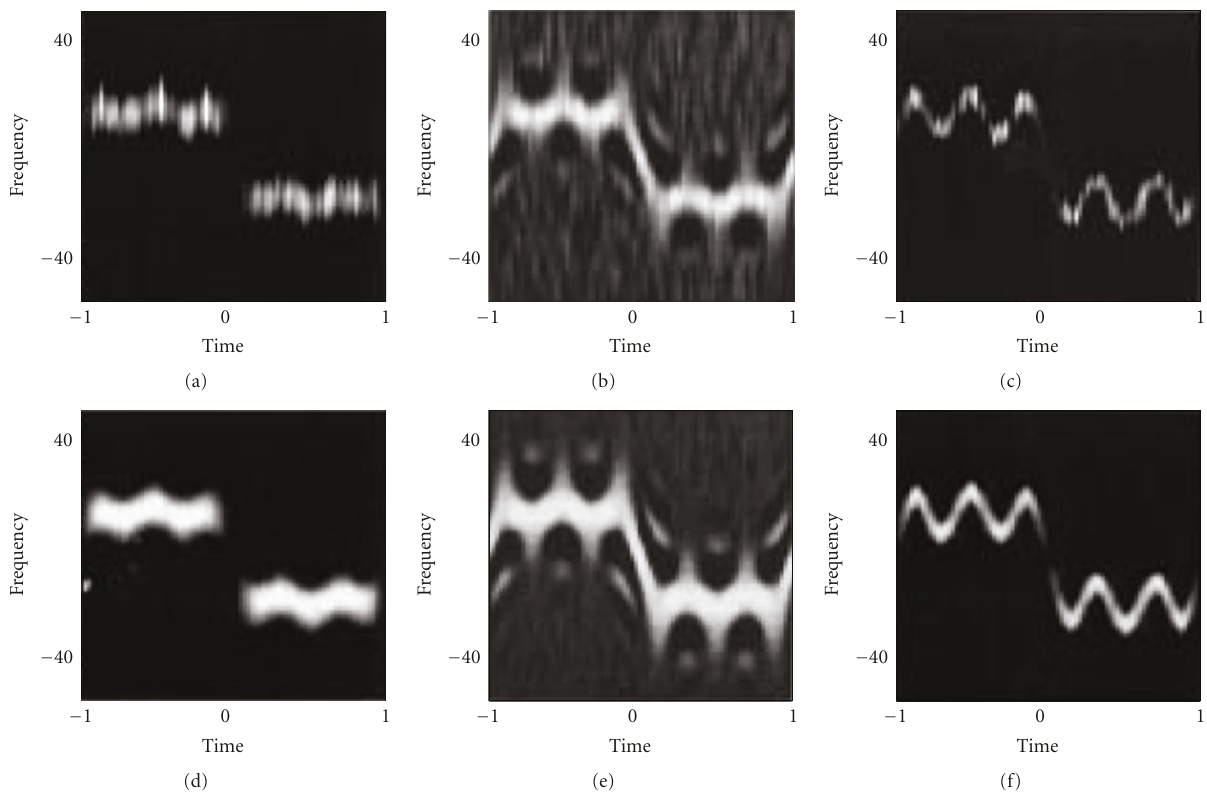
Figure 18: TFD of a signal with highly nonlinear IF. Spectrogram (a), (d), WD (b), (e), complex-lag distribution (c), (f). (a), (b), and (c) signals with a relatively high noise SNR = 10dB. (d), (e), and (f) signals with a small noise SNR = 30dB (all adopted from Stankovic [165]).